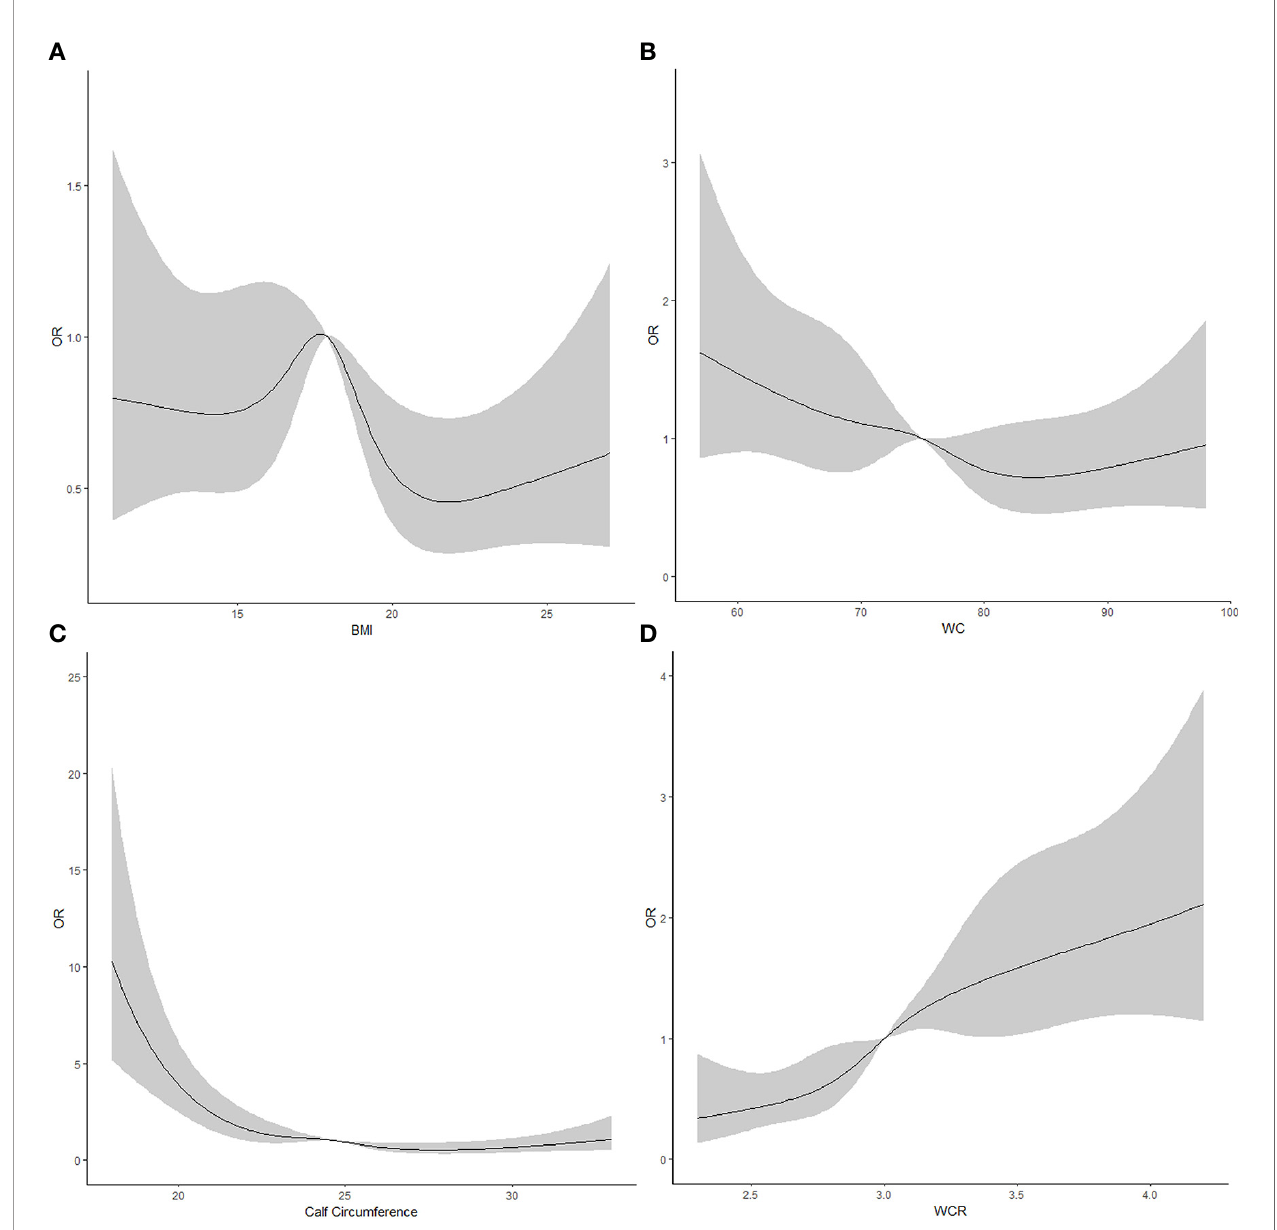
FIGURE 1 | Restricted cubic splines assessing the association between (A) body mass index, (B) waist circumference, (C) calf circumference, and (D) waist-calf circumference ratio and the risk of moderate and severe activity of daily living disability after adjusting for gender, age, ethnicity, educational level, residential type, smoking, drinking, and physical